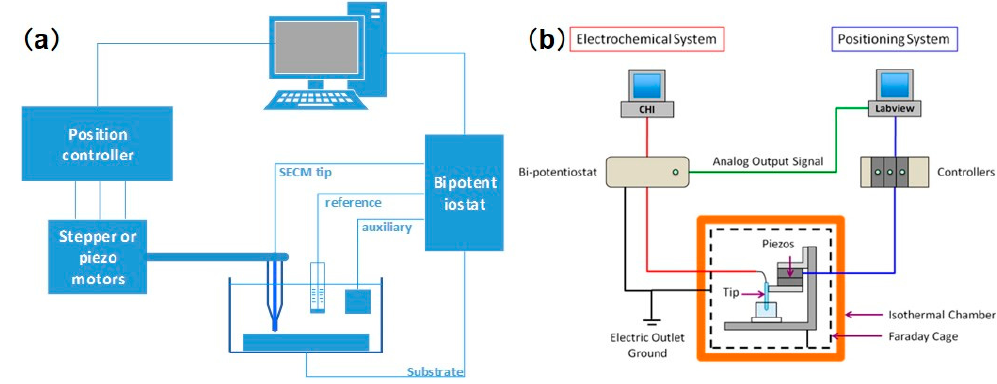
Figure 1. ( a ) Schematic diagram of the conventional scanning electrochemical microscopy (SECM) apparatus; ( b ) Schematic diagram of the modified SECM. Copyright (2016) American Chemical Society.